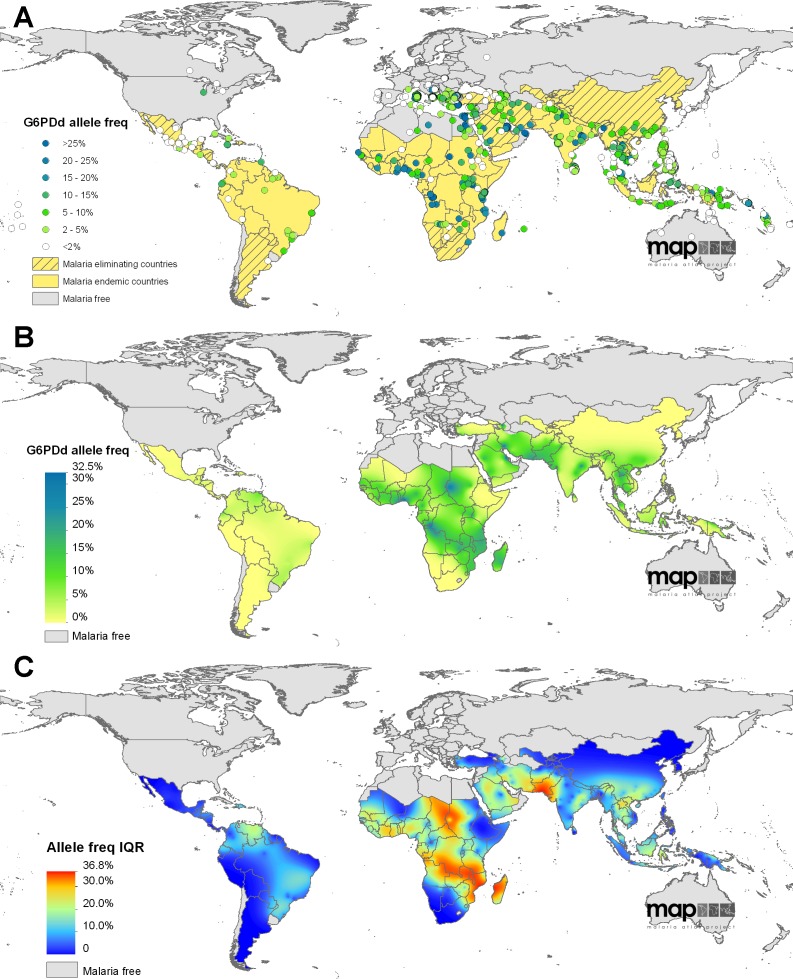
The global distribution of G6PDd.(A) shows the global assembly of G6PDd community surveys included in the model dataset; data points are coloured according to the reported prevalence of deficiency in males (n = 1,720). Background map colour indicates the national malaria status (malaria free/malaria endemic/malaria eliminating). (B) is the median predicted allele frequency map of G6PDd. (C) presents the associated prediction uncertainty metrics (IQR); highest uncertainty is shown in red and indicates where predictions are least precise.